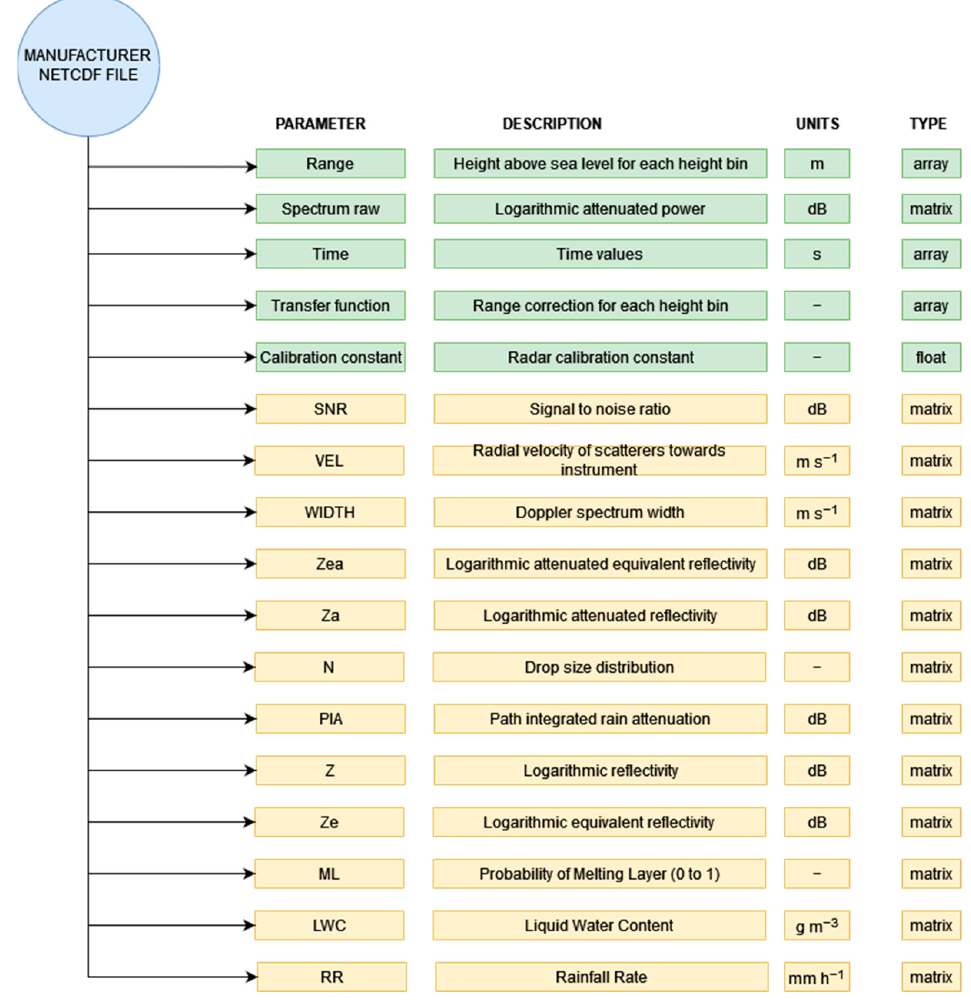
Figure 1. Description of selected parameters contained in the manufacturer’s netcdf file. Parameters in green are required by the proposed methodology implemented in RaProM- Pro .